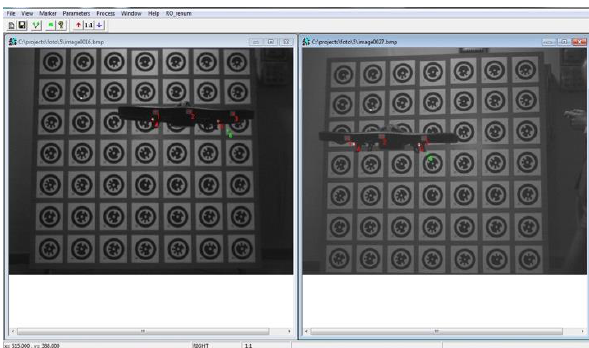
Figure 8. Hercules skied-steered robot with targets